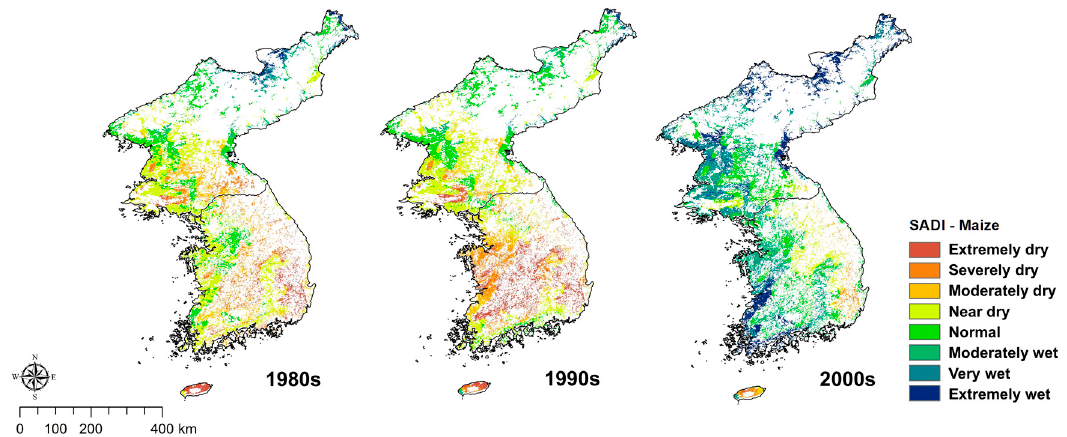
Figure 7. Spatial distribution of the Standardized Agricultural Drought Index for maize (SADI-Maize) in the 1980s, 1990s, and 2000s.